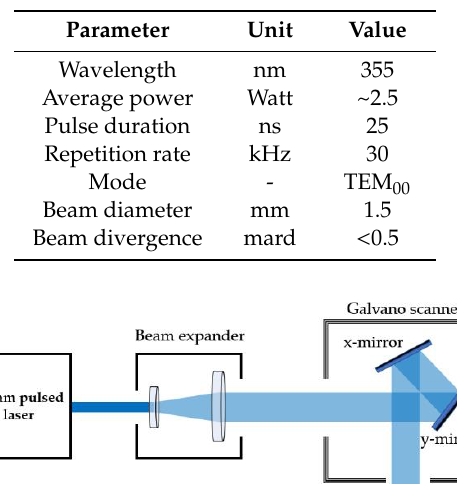
Table 1. Specifications of the 355 nm UV pulsed laser.